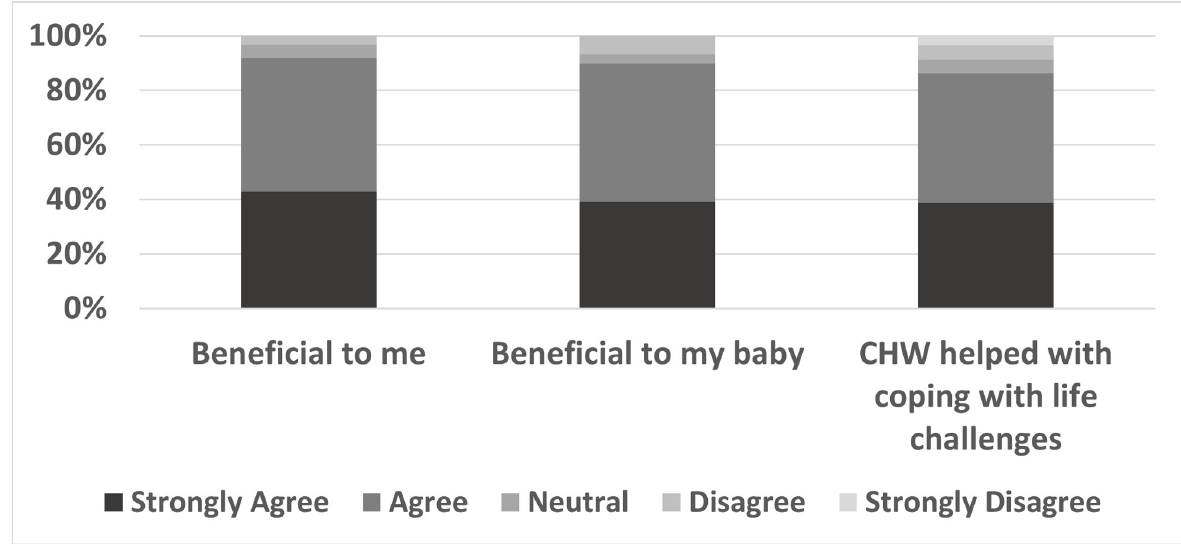
Fig 1. Summary of WIN Network participants’ views of participating in WIN Network and how their community health worker (CHW) helped 2–3 years after participating.